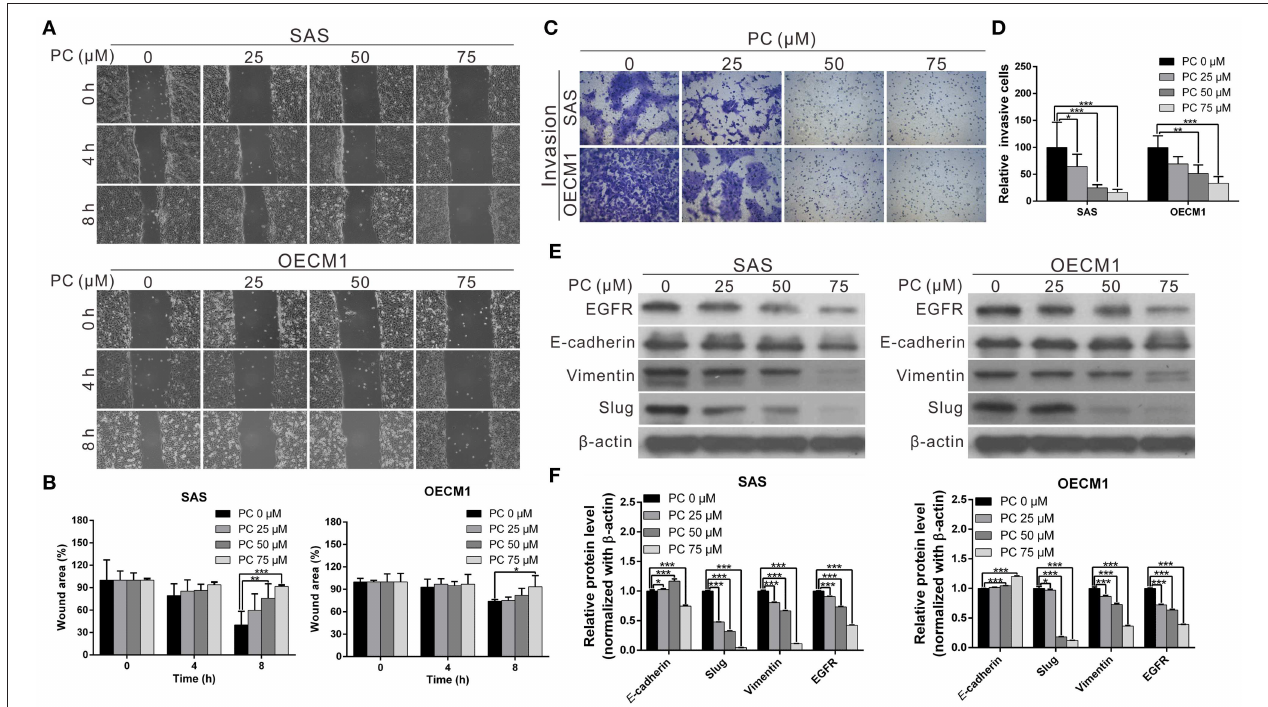
FIGURE 3 | Inhibition of cell metastasis ability in OSCC by psorachromene by inhibition of the progression of epithelial-mesenchymal transition. (A) The effect of psorachromene on the wound-healing ability of SAS and OECM1 cells. Quantitative results are seen in (B) . (C,D) The effect of psorachromene on the invasiveness of SAS and OECM1 cells. (E) Western blotting was used to examine the levels of EMT regulatory proteins in OSCC cells treated with psorachromene for 48h. The quantified results are shown in ( F ). * p < 0.05, ** p < 0.01, *** p < 0.001.